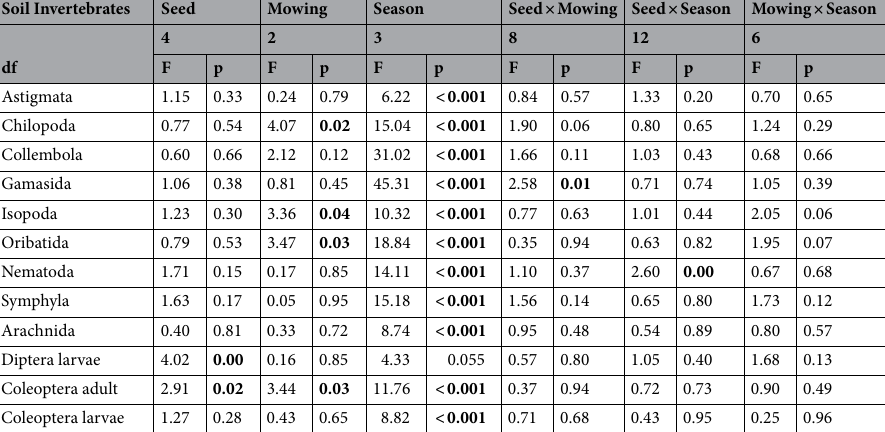
Table 3. The statistical summary of the effects of experimental treatments and their interactions on abundance of the soil invertebrates. Bold values indicate significant